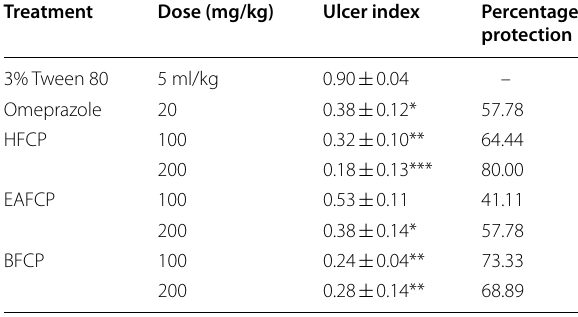
Table 5 Effect of fractions of C. paniculatum on absolute ethanol-induced ulcer in rats